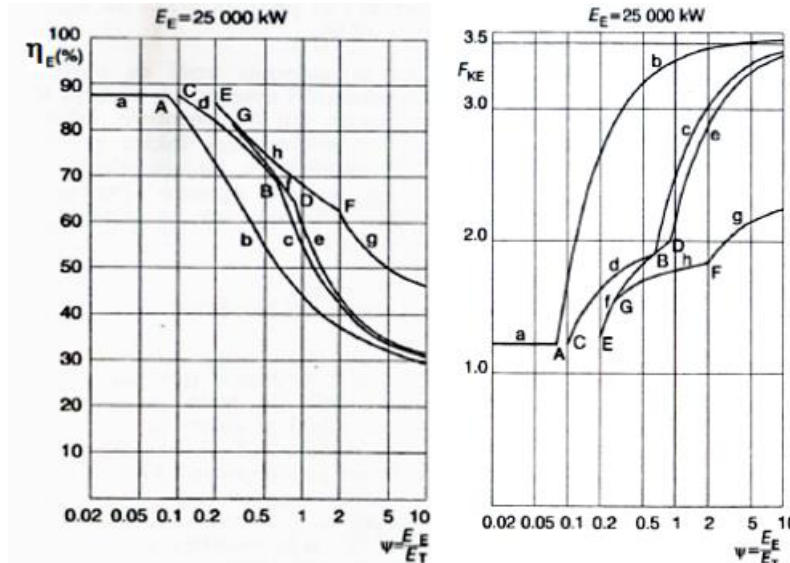
Fig. 5. Energy efficiency ɳ